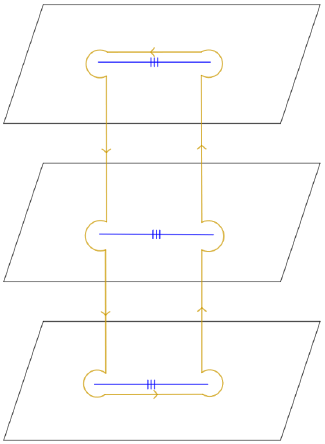
Figure 6 . A (brown) closed contour without touching the (blue) branching cuts representing the boundary interval A in the abelian orbifold Σ for computing entanglement entropy. The total shift 3 in y direction is zero if we go around the contour counter-clockwise following the